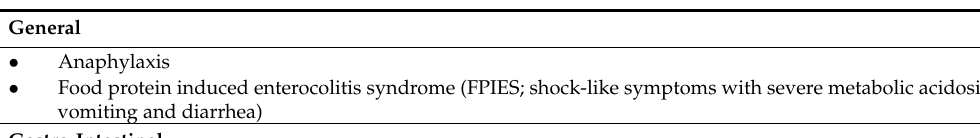
Table 1. Symptoms and signs related to